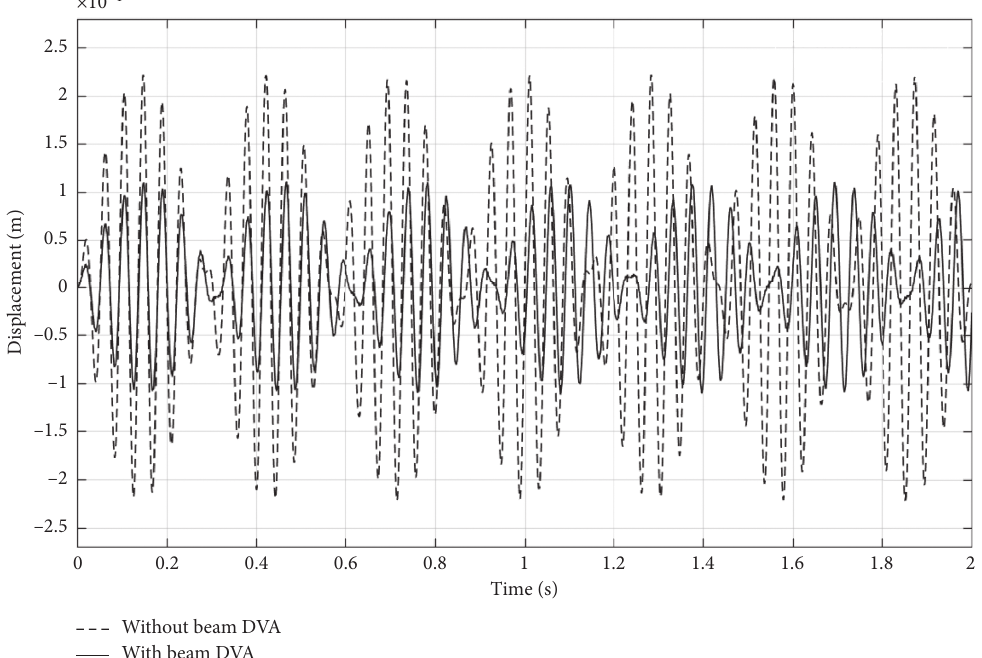
Figure 13: Numerical results of the 3-inch pipeline structure under the excitation frequency of 22Hz.